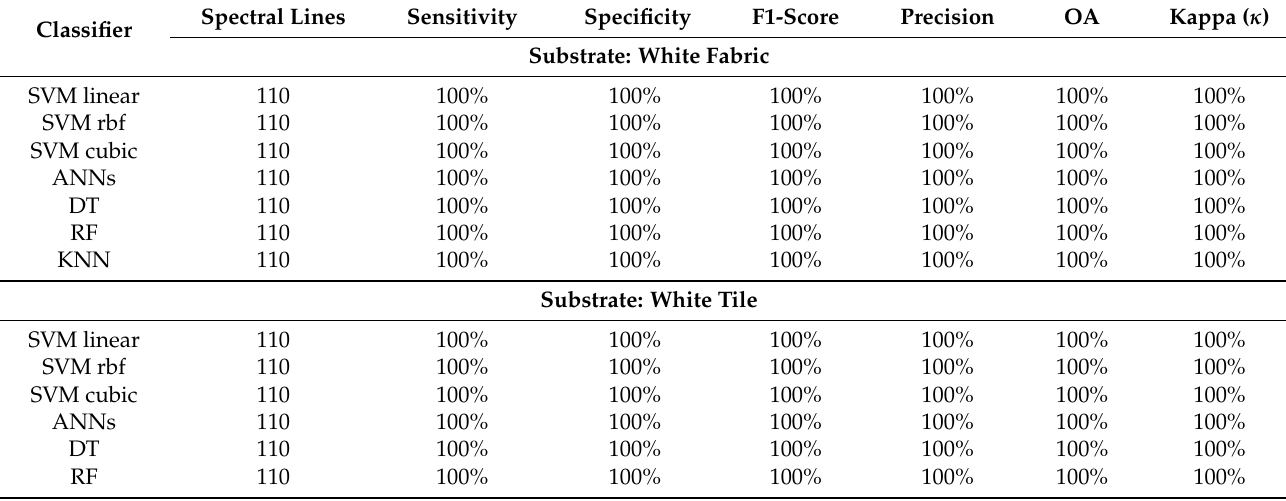
Table 5. Blood (donor 1) vs. non-blood experimental results over pixel based data splitting. Similar results are observed for other